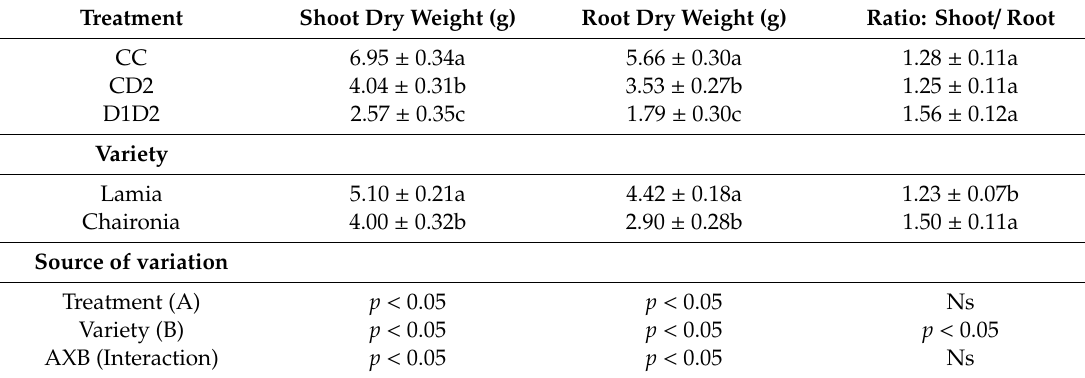
Table 2. Mean values +/ − SE for each of the three di ff erent treatments (CC, CD2, and D1D2), as well as for each of the two varieties tested. Statistically significant di ff erences between treatments (A), between varieties (B), and their interaction (AXB) are also